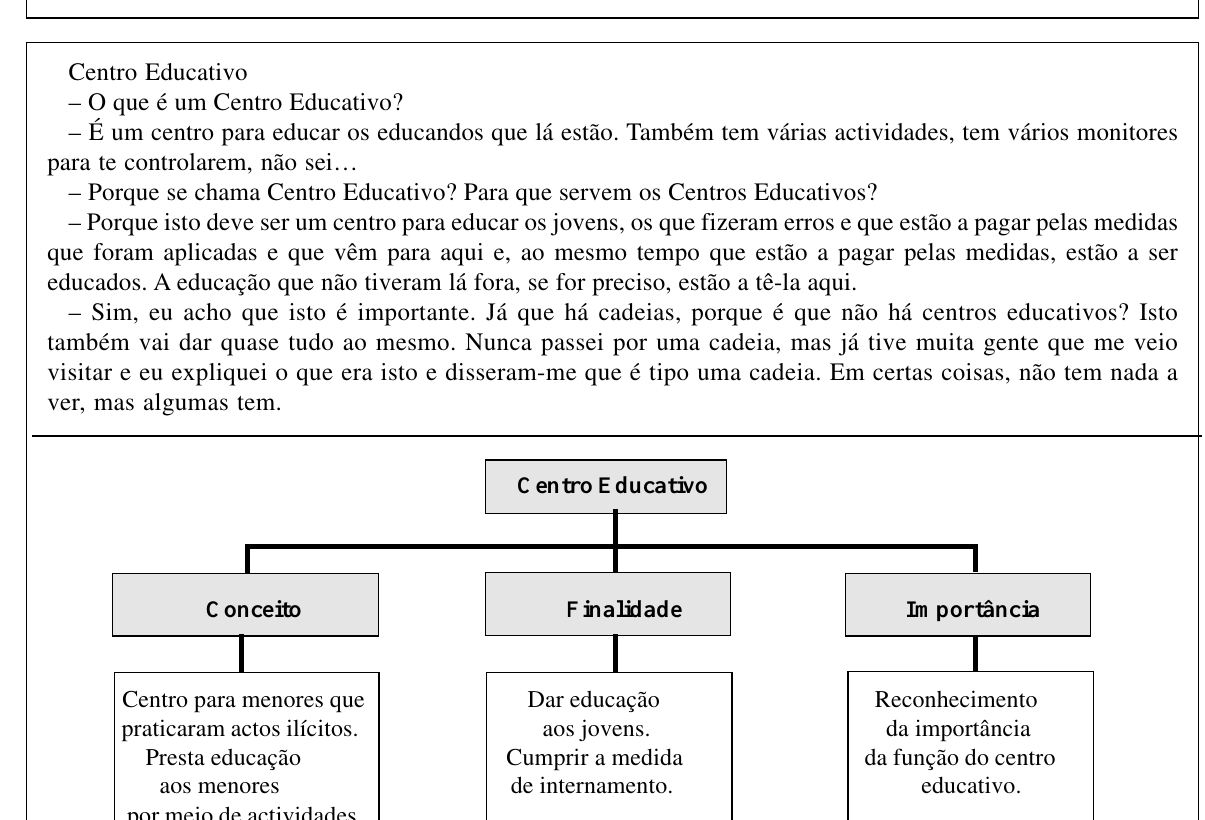
Figura 1 . Excerto de entrevista e respectivo mapa conceptual de T.G.E. Categoria: ordem jurídica. Subcategoria: